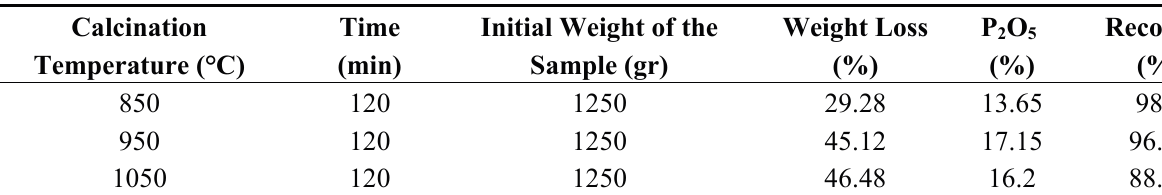
Table 6. Results of calcination test fractional class of 0.15–2.4-mm.